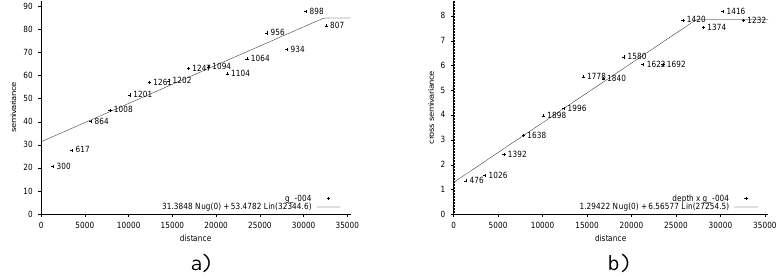
Figure 2. a) semivariogram of fraction (7) where Md of sediments is less than 0.004; b) cross semivariogram between fraction (7) and depth of the Curonian